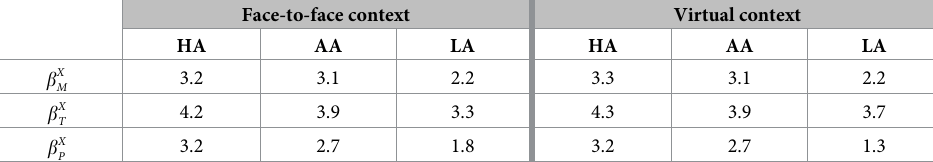
, b X and b X obtained by ANN. M T P